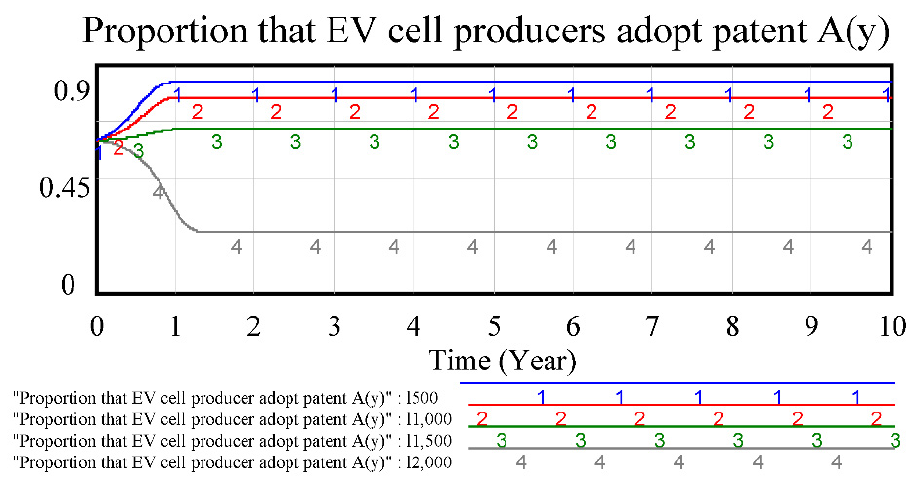
Figure 5. Sensitivity test of factor l that impacts EV cell producer.